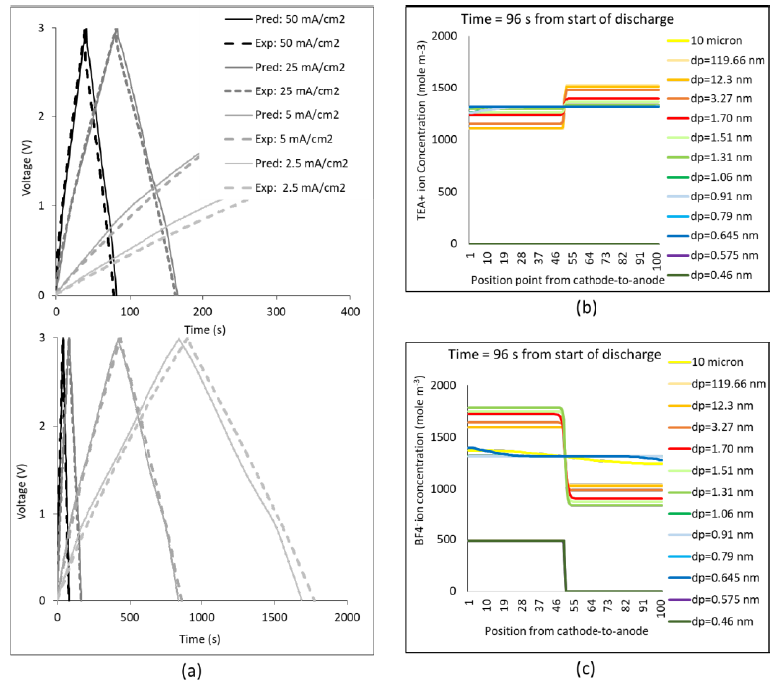
Figure 5. ( a ) Predicted GCD curves for Case A (4 cm 2 electrochemical double-layer capacitor (EDLC) cell, with ACF electrodes and 1.5 M TEABF 4 /AN electrolyte) and experimental data [18,62]. ( b , c ) Ion concentration profiles across the EDLC cell thickness 95 s after the start of discharge in GCD cycle at 2.5 mA cm −2 for Case A: cell thickness in Case A is 1 mm consisting of 0.5 mm cathode and 0.5 mm anode (separator is considered fully permeable by ions and of negligible thickness).